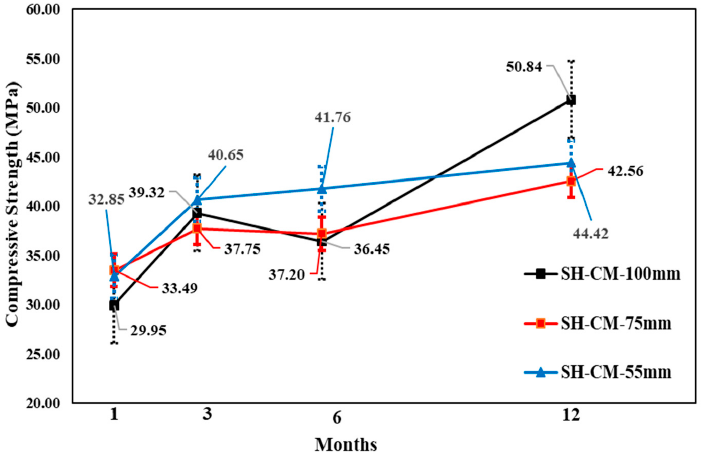
Figure 11. Core compressive strength of cement mineral accelerator mixture by age.